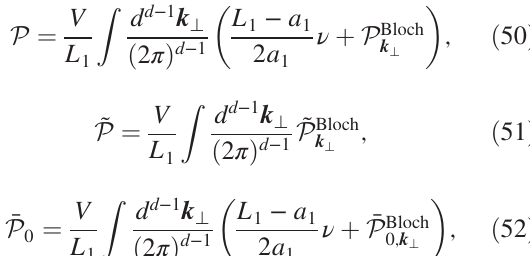
The Hamiltonian contains only an intracell hopping t 0 > 0 .